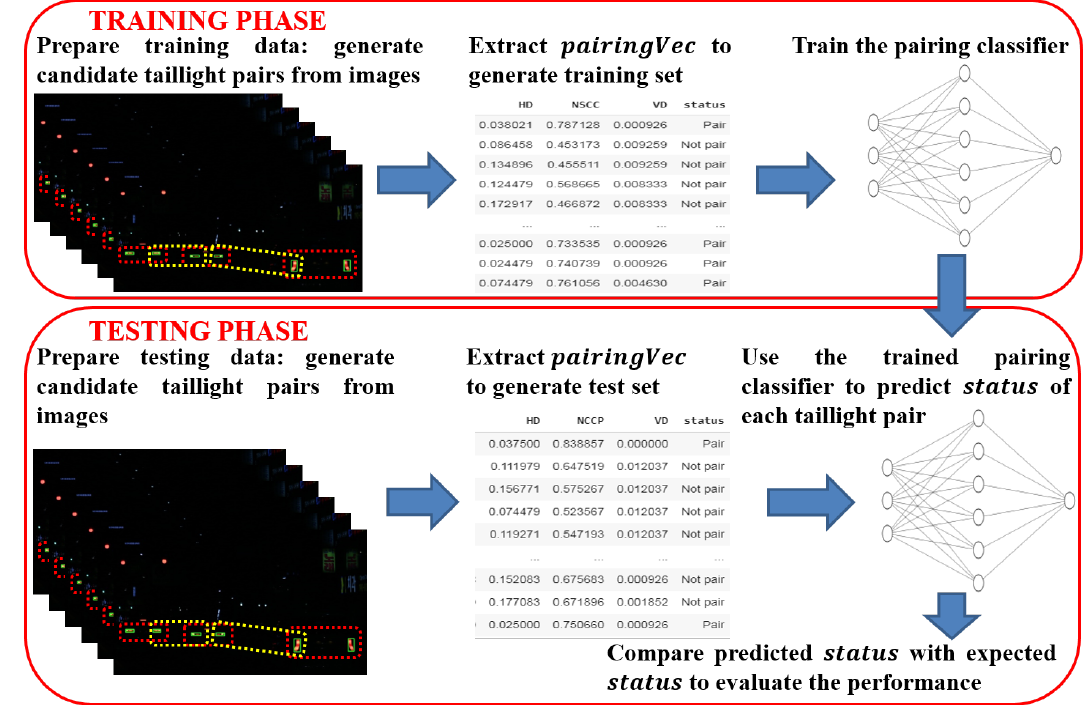
Figure 27. Building dataset for constructing and evaluating